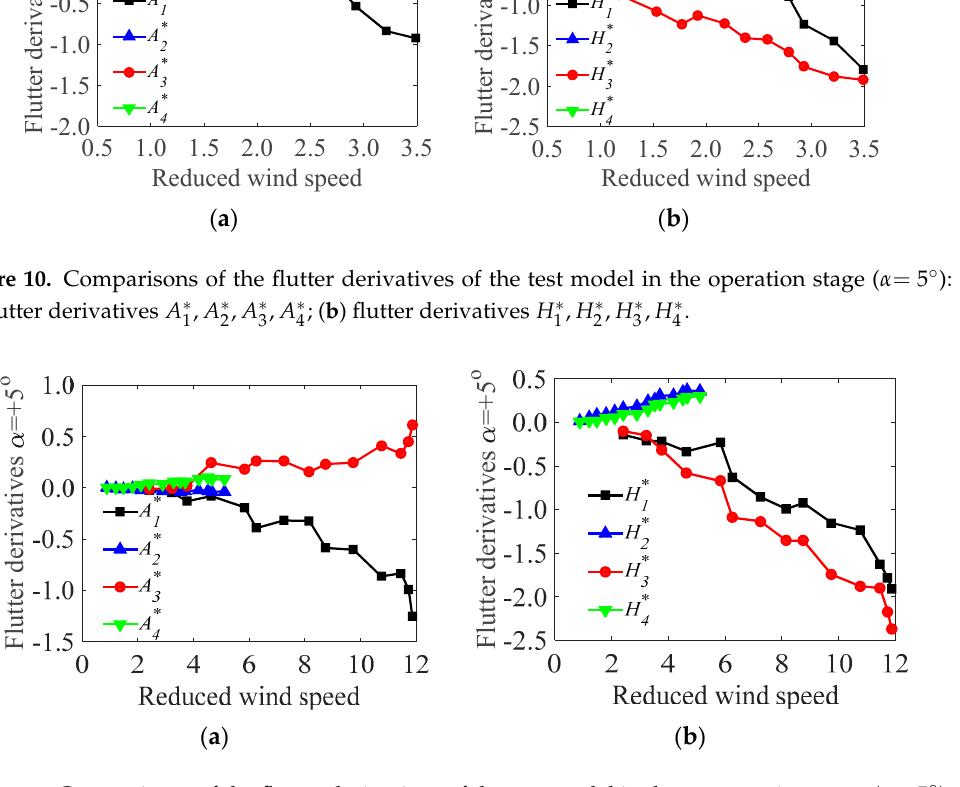
Figure 11. Comparisons of the flutter derivatives of the test model in the construction stage ( α = 5 ◦ ): ( a ) flutter derivatives A ∗